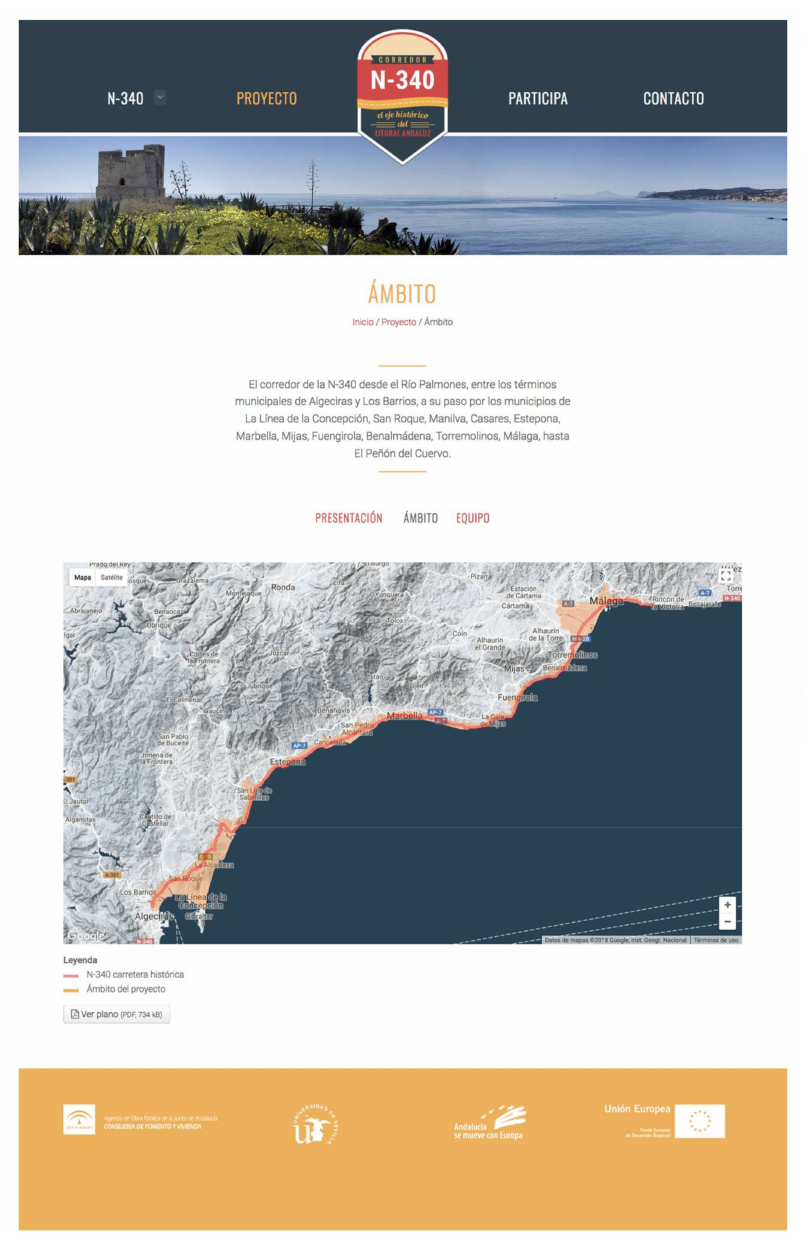
Figure 2. Area of study. Screenshot by the N-340 research team, January 2018 (https://n-340.org/ proyecto/ambito/). The historic path of the N-340 roadway is marked in red. The area of study is shaded in semitransparent orange. A corresponding map created in GIS software is available for download in